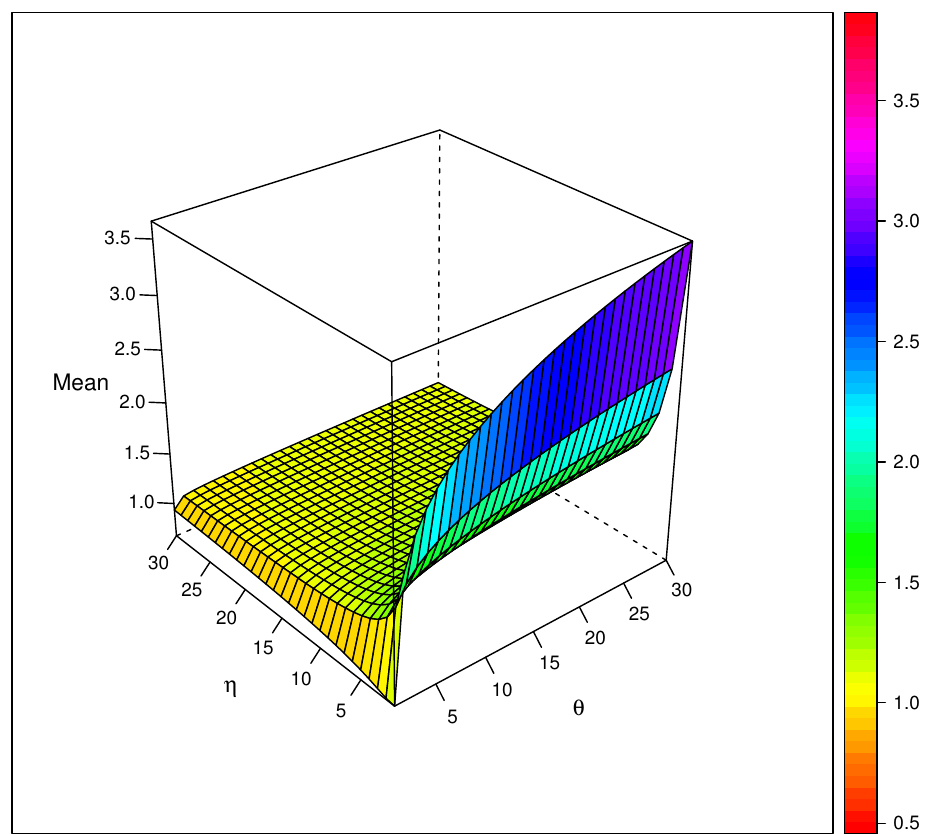
Figure 2. Mean plot of an EEP distribution with different parameters.